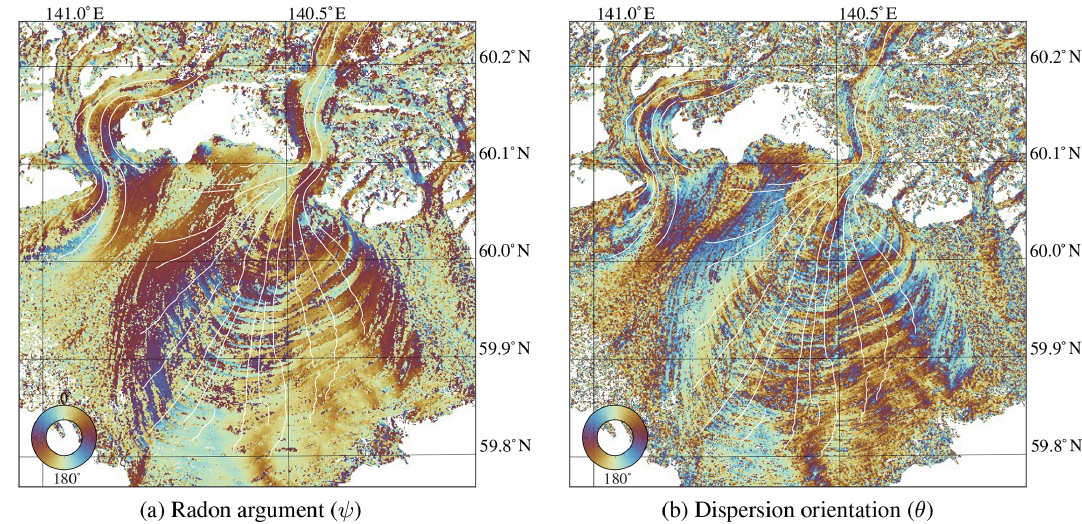
Figure 7. Orientation descriptors over the Malaspina case study, estimated through Radon transform (Fig. 9a) and correlation spread (Fig.